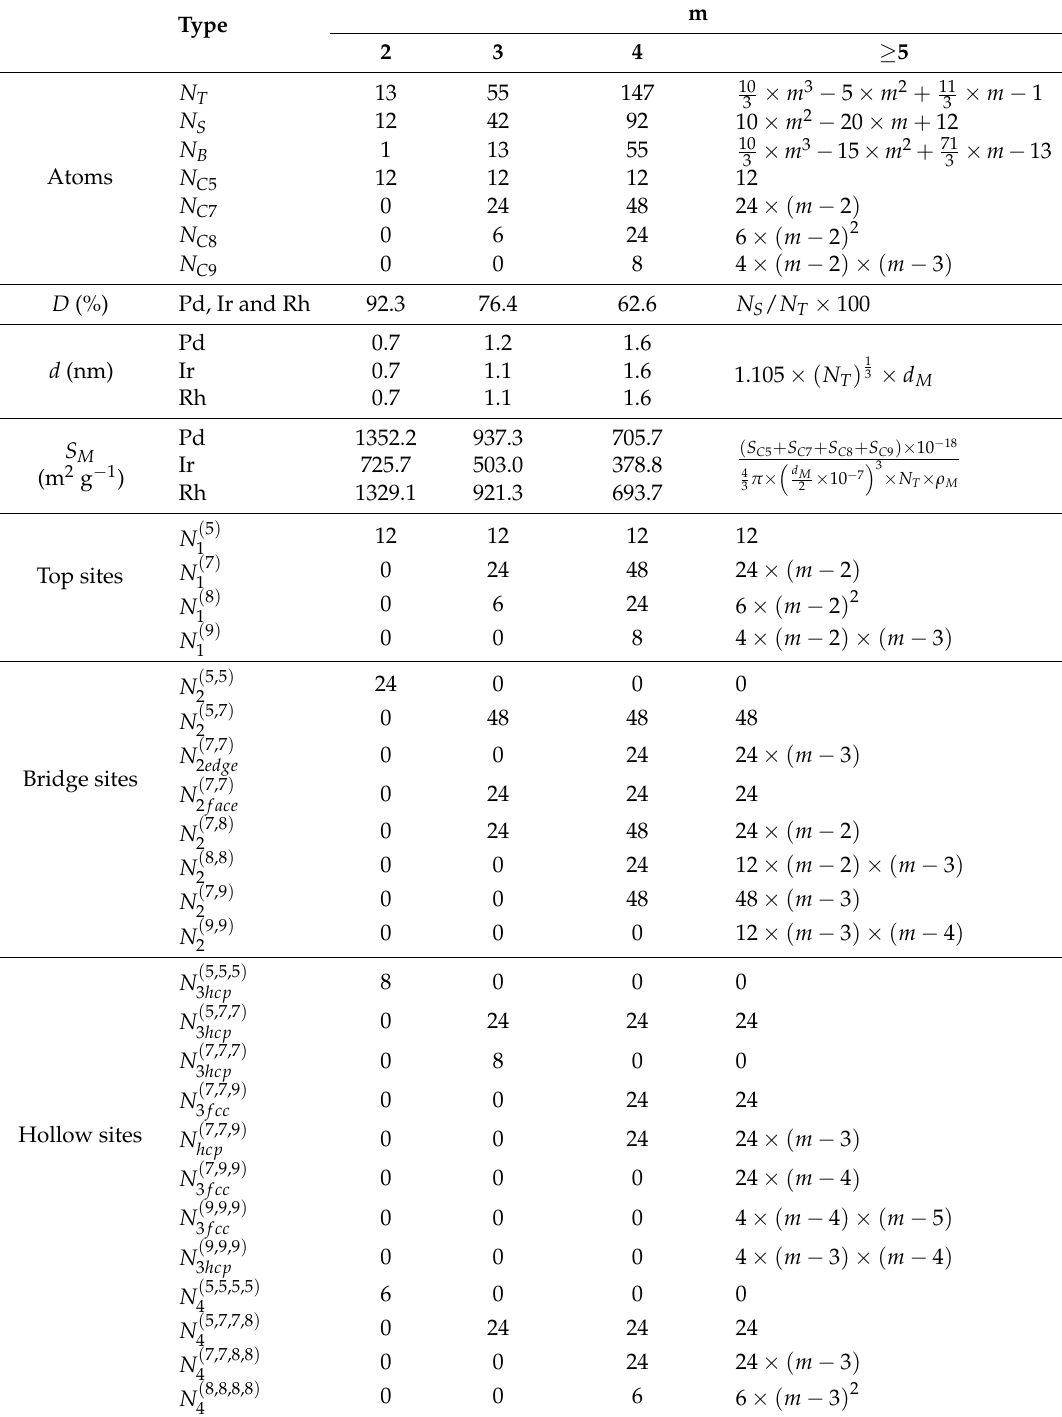
Table 1. Statistics of atoms, dispersion, size, metallic specific surface area, and adsorption site numbering for metal cuboctahedron cluster. d M and ρ M represent the metallic diameter ( d Pd = 0.274 nm, d Rh = 0.270 nm and d Ir = 0.272 nm ), and the density of the metal represent the surface area of the surface atom of type N C5 , N C7 , N C8 , and N C9 , respectively (for more details, see ref.